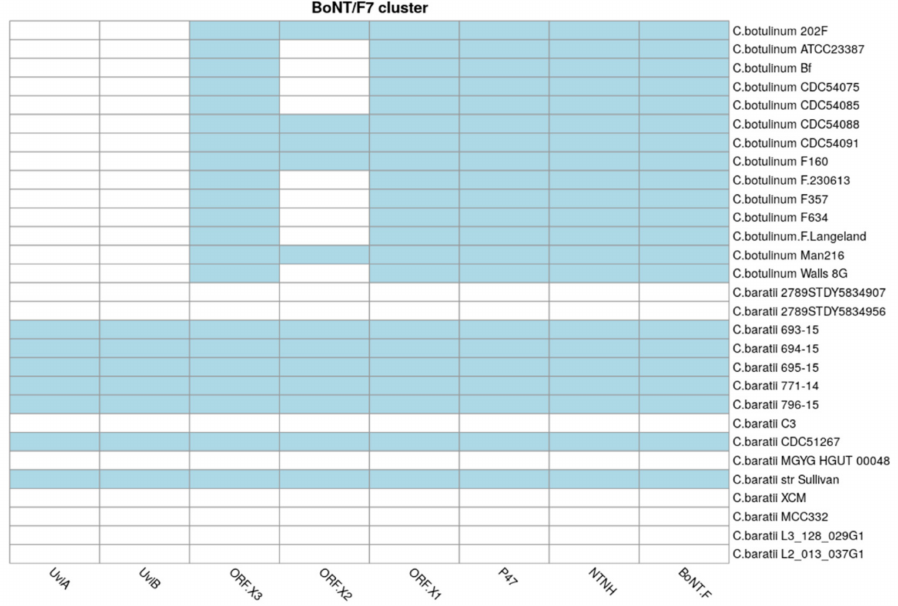
Figure 7. BoNT toxin cluster. Presence (in blue) or absence (in white) of BoNT toxin cluster genes in C. baratii and C. botulinum strains. The x-axis represents BoNT cluster genes, and the y-axis represents the strains.